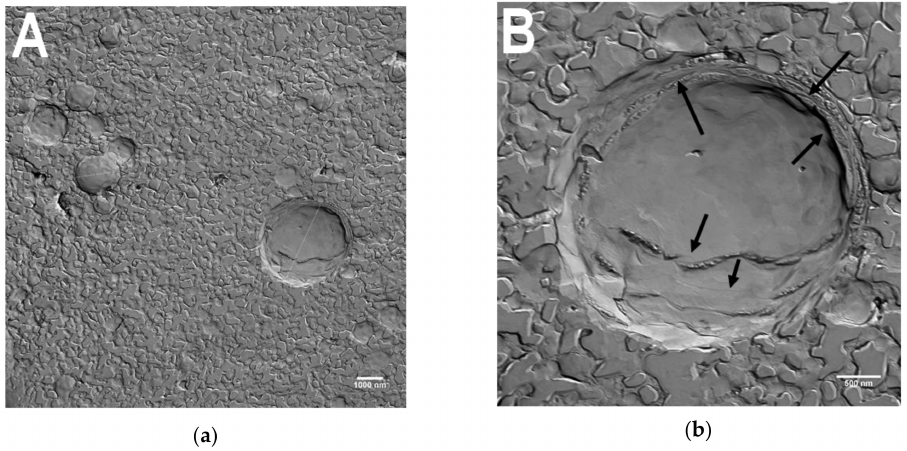
Figure 2. TEM images of freeze-etched liposomes. ( A ) Overview. The diameter of liposomes reaches from ca. 400 nm to ca. 3000 nm. Bar measures 1000 nm. ( B ) Multiple lipid layers can be observed (arrows). Bar measures 500 nm.